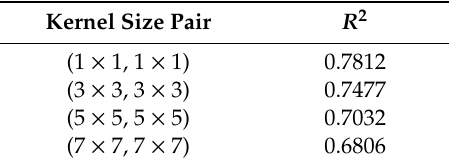
Table 6. Comparison of kernel selection options in our model (coe ffi cient of determination, R 2 ) Kernel Selection